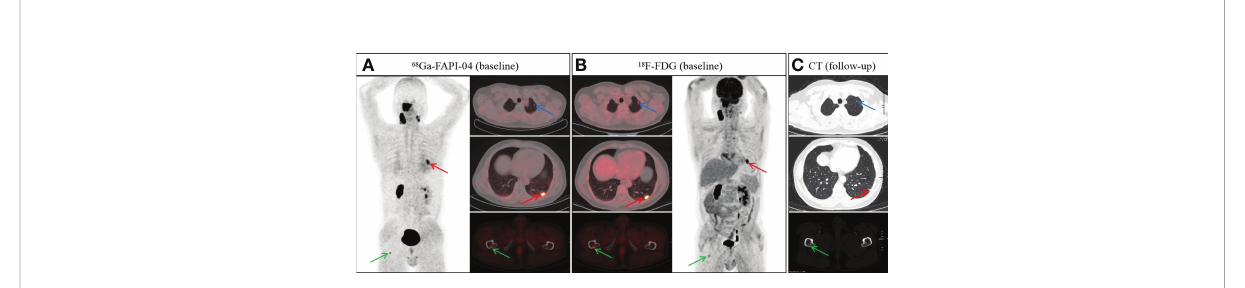
FIGURE 4 A 48-year-old man with nonkeratinizing undifferentiated carcinoma. 68 Ga-FAPI-04 (A) and 18 F-FDG PET/CT (B) revealed an abnormal nodule in the left lower lobe ( A , red arrow, SUVmax 4.9 vs. B, red arrow, SUVmax 8.2). However, the nodule in the left upper lobe showed abnormal uptake on 18 F-FDG PET/CT ( B , blue arrow), but not on 68 Ga-FAPI-04 PET/CT ( A , blue arrow). In addition, both 68 Ga-FAPI-04 ( A , green arrow) and 18 F-FDG PET/CT ( B , green arrow) revealed abnormal activity in the right femur. Follow-up CT after two cycles of induction chemotherapy showed a reduction in the volume of pulmonary metastases ( C , red and blue arrow). Meanwhile, the bone metastasis of the right femur revealed a repair response after treatment, showing osteosclerotic nodule on follow-up CT ( C , green